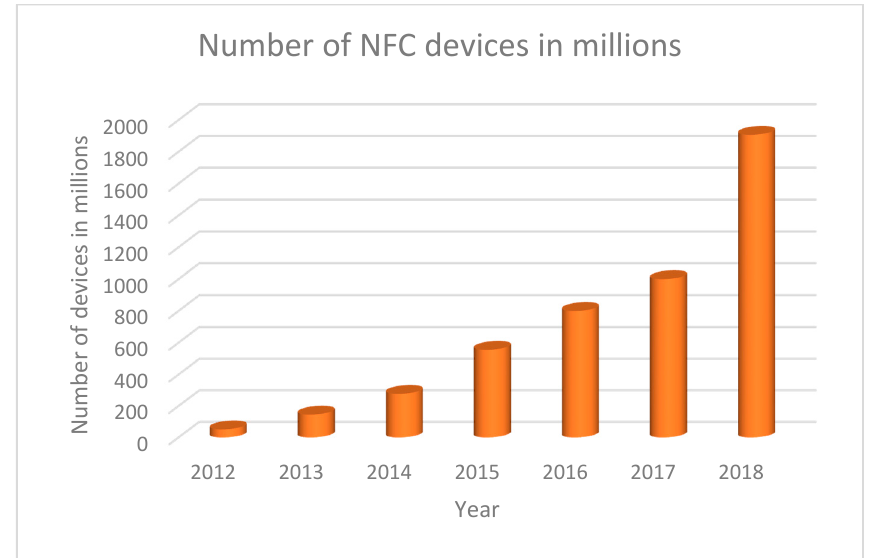
Figure 12. Number of NFC-enabled mobile devices worldwide from 2012 to 2018 (in millions of units).